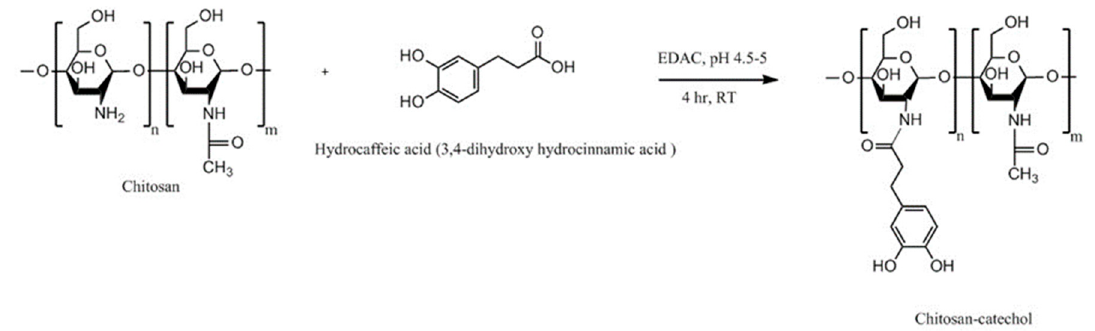
Figure 19. Synthetic pathway to chitosan-catechol using carbodiimide chemistry [141].